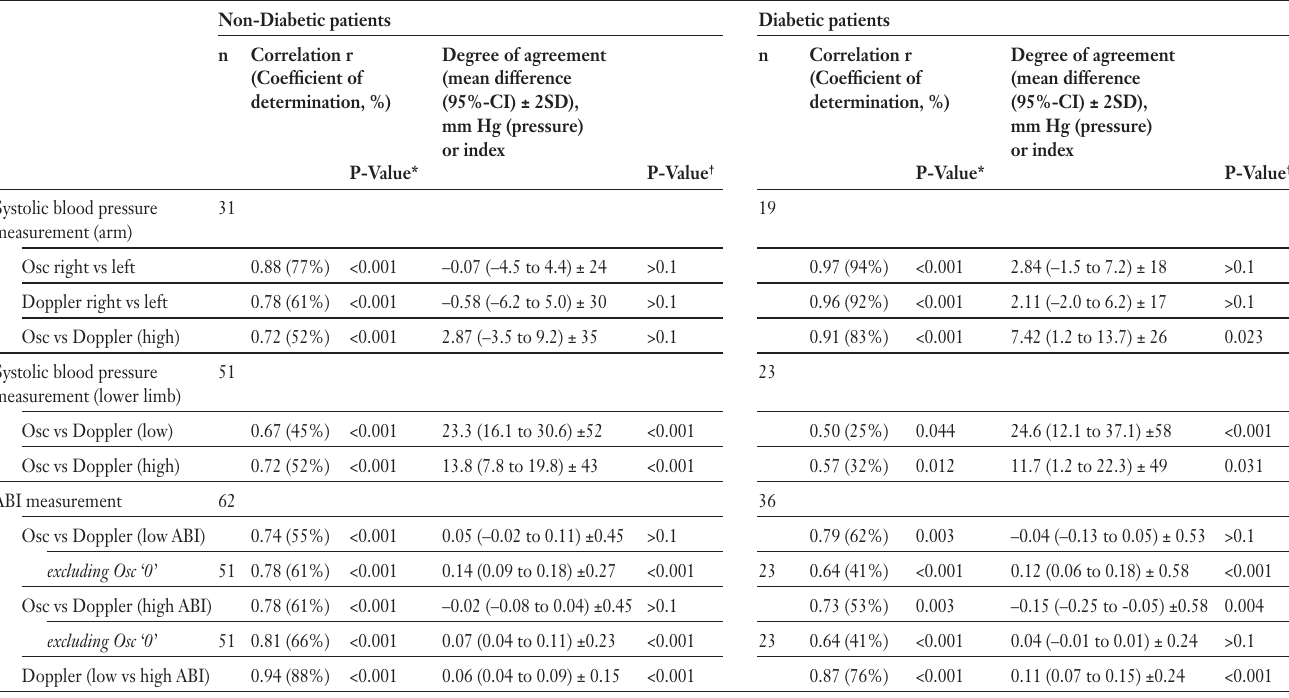
Main validation results of oscillometric measurement of ankle brachial index, stratified for presence of diabetes. Non-Diabetic patients Diabetic